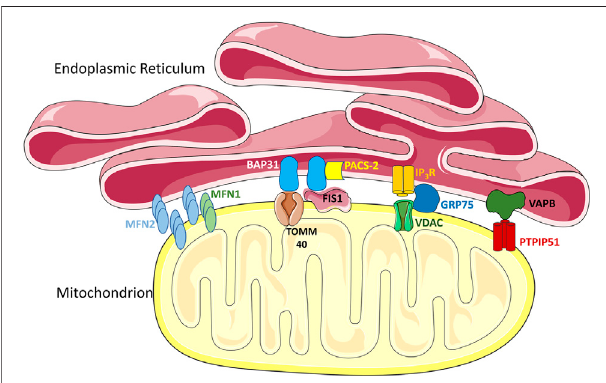
FIGURE 2 | MERC tethers. Multiple proteins in the ER and the outer mitochondrial membrane (OMM) act as tethering complexes that can stabilize MERCs. Notably, MFN2 can localize on both the mitochondrial outer membraneand the ERmembrane, allowing MFN2 on theERmembrane to form homotypic contacts with MFN2 or heterotypic contacts with MFN1 on theOMM.BAP-31ontheERmembranecanbindtoTOMM40andFIS1inthe OMM,interactionswhicharemediatedbyPACS-2.InteractionsbetweenIP 3 R intheERandVDACsintheOMM,aremediated via GRP75,andareimportant in mediating Ca 2+ transfer. Another interaction shown is between VAPB in the ER and PTPIP51 in the mitochondria, which forms a key tethering complex regulating the spatial conformation of MERCs. The schematics used in the fi gures were taken from Smart Servier (2021).